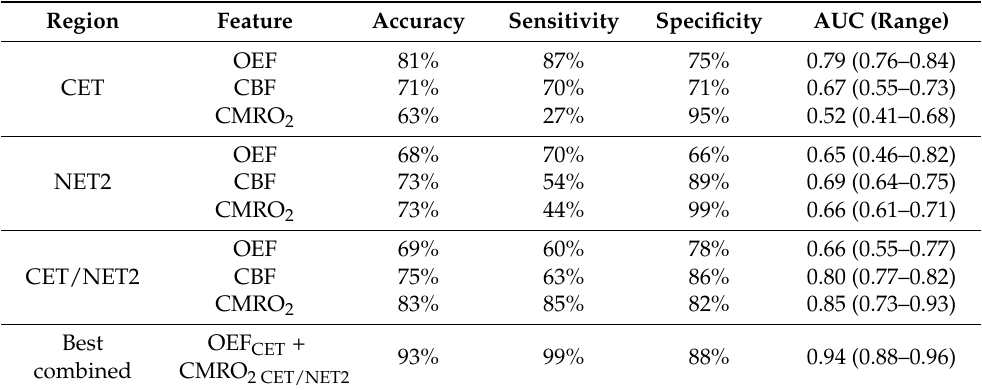
Table 1. Receiver operating characteristic analysis results of a linear kernel support-vector machine trained on oxygenation and perfusion